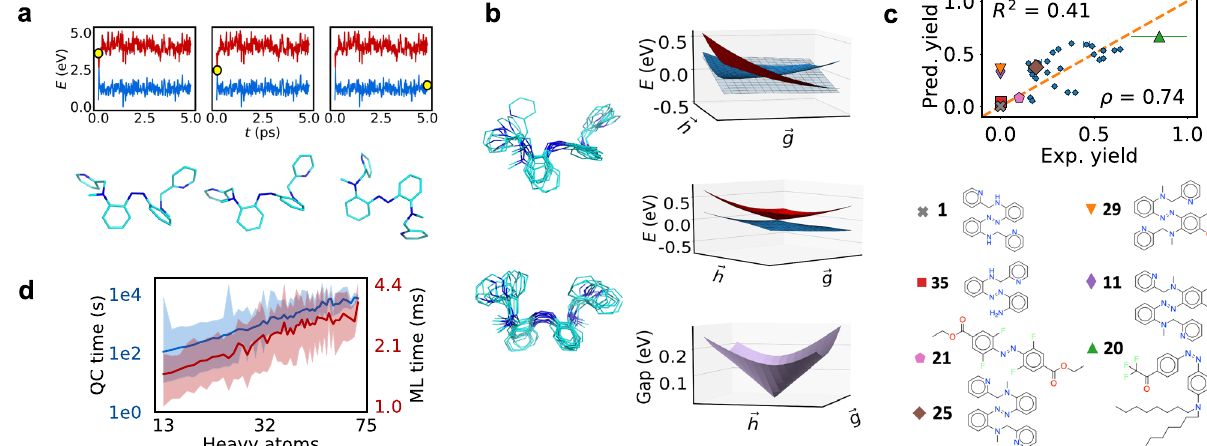
Fig. 3 Speed and accuracy of DANN-NAMD. a Selected trajectory frames for a molecule outside the training set. The top panels show the S 0 and S 1 energy as a function of time. A yellow dot indicates the time at which the snapshot below was taken. b Left: Overlay of selected hopping geometries from reactive (top) and unreactive (bottom) trajectories. Right: PES as a function of branching plane coordinates at one of the reactive hopping geometries. Diabatic energies, adiabatic energies, and adiabatic gaps are shown from top to bottom. The diabatic coupling is shown in gray. c Predicted vs. experimental quantum yield for 33 species outside the training set. The R 2 value and Spearman rank correlation ρ are both shown. Color-coded data points are de fi ned below. Prediction error bars represent one standard deviation of 1000 bootstrapped samples. Experimental error bars represent reported uncertainties or standard deviations from multiple observations, when applicable. d Node time for QC and ML